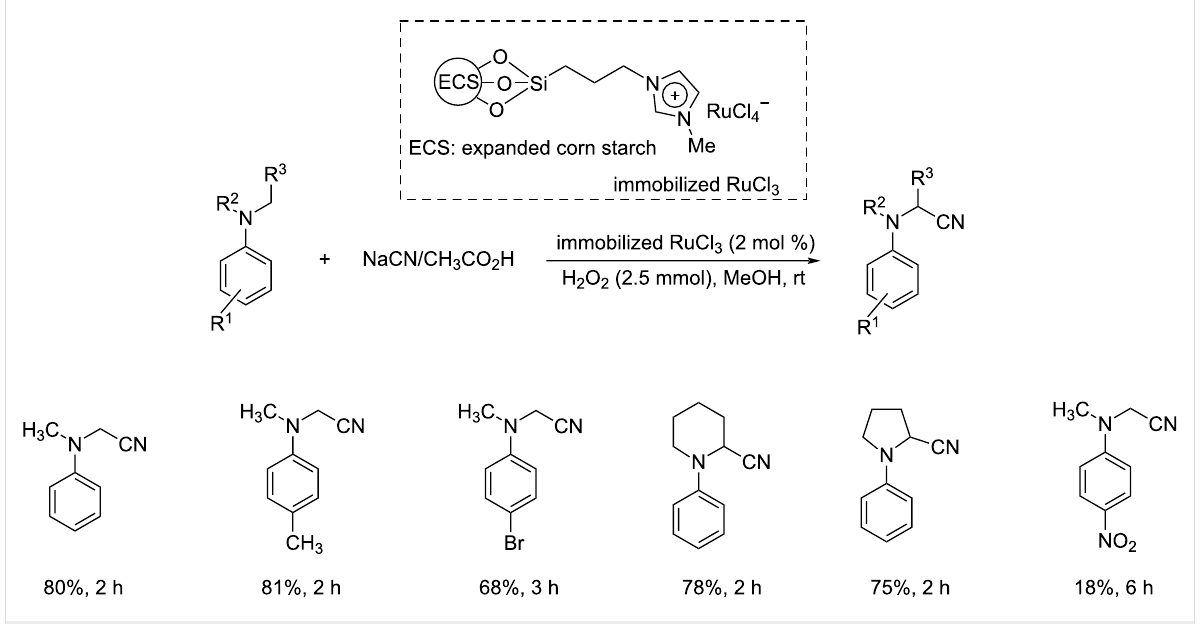
Scheme 1: Starch-immobilized ruthenium trichloride-catalyzed cyanation of tertiary